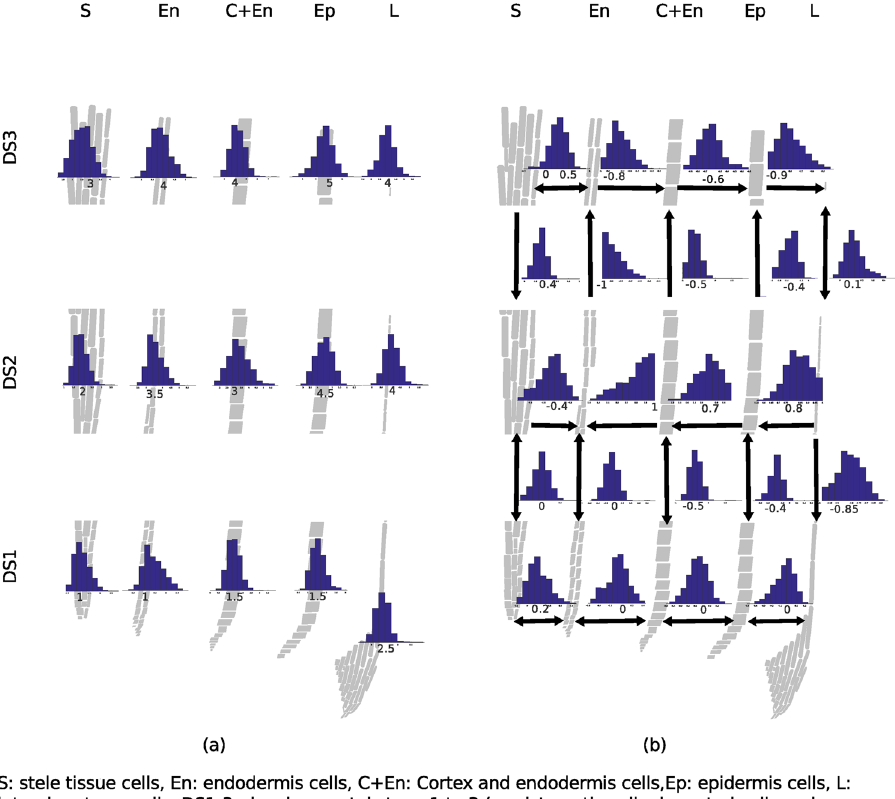
Figure 6. Indole-3-acetate behavior in the root. Fluxes for the extracted models are sampled uniformly by employing the hit-and-run algorithm. ( a ) The flux-sum of IAA in each of the cell types. ( b ) Fluxes through IAA transport reactions. The distribution of samples fluxes determines the preferred direction of the IAA flow when boundaries at optimum